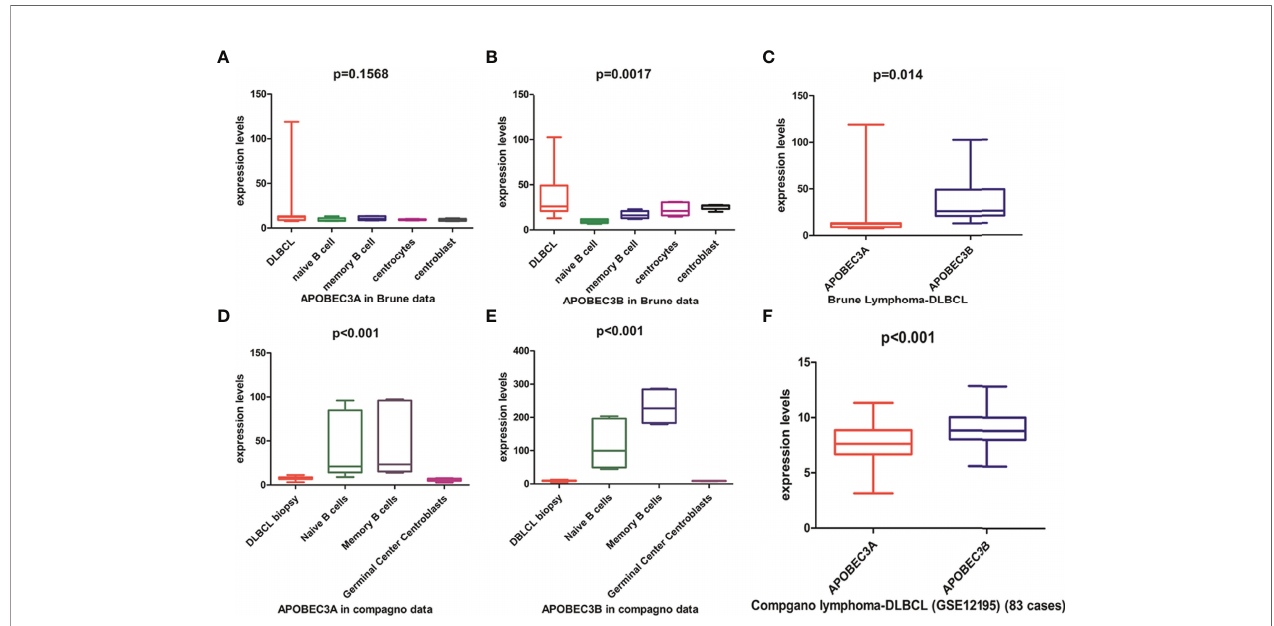
FIGURE 4 | APOBEC3A and APOBEC3B expression in DLBCL based on the Oncomine online database. (A, B) APOBEC3A (A) and APOBEC3B (B) expression in the Brune lymphoma dataset including DLBCL, naïve B cells, memory B cells, centrocytes, and centroblasts. (C) Comparison of APOBEC3A and APOBEC3B expression in the Brune lymphoma dataset. (D, E) APOBEC3A (D) and APOBEC3B (E) expression in the Compagno lymphoma dataset including DLBCL, naïve B cell, memory B cell, and germinal center centroblasts. (F) Comparison of APOBEC3A and APOBEC3B expression in the Compagno lymphoma dataset.